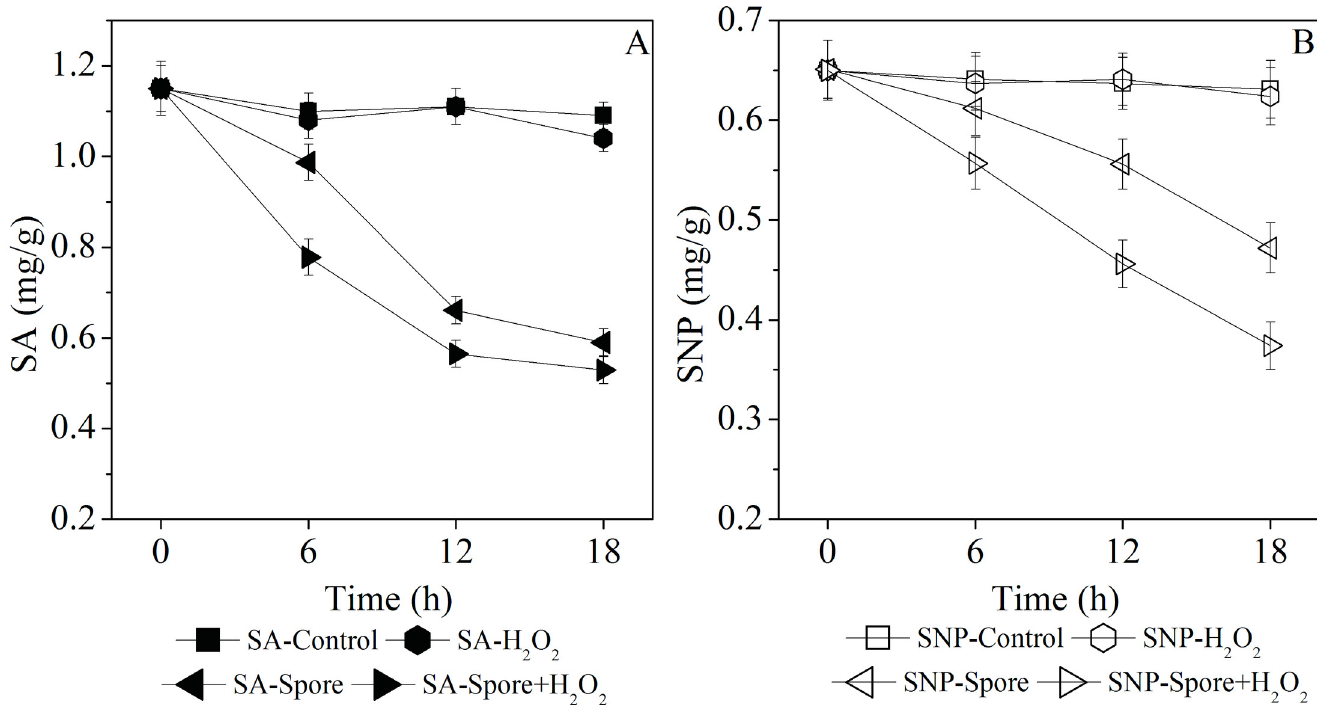
treated with the spore suspension plus 15 mM H O . The content of SA was not reduced by 2 2 O for treating RSM. Similar changes were also observed in the the sole use of 15 mM H 2 2 amount of SNP extracted from RSM (Fig 6B). Without any treatment, approximately 0.65 mg/ g of SNP was extracted from RSM. Following treatment of RSM with the spore suspension, the amount of SNP decreased to 0.47 mg/g. The amount of SNP further decreased to 0.37 mg/g O to the spore suspension. Compared with the controls, a simi- with the addition of 15 mM H 2 2 lar amount of SNP was extracted from the RSM treated with H O . In conclusion, the SA and 2 2 SNP content decreased by 46 and 25% after treating RSM with the spore suspension for 18 h. The SA and SNP content decreased approximately 51 and 41% after RSM was treated with the O . These results demonstrated that the spores were efficient spore suspension plus 15 mM H 2 2